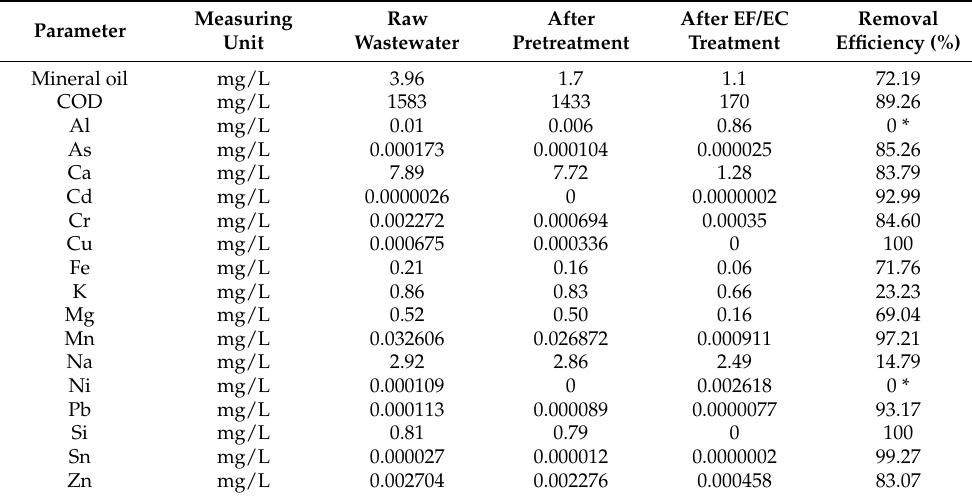
Table 3. Chemical parameters determined in untreated oily wastewater, after primary sedimentation of raw wastewater and after EF/EC process, and final removal efficiency.